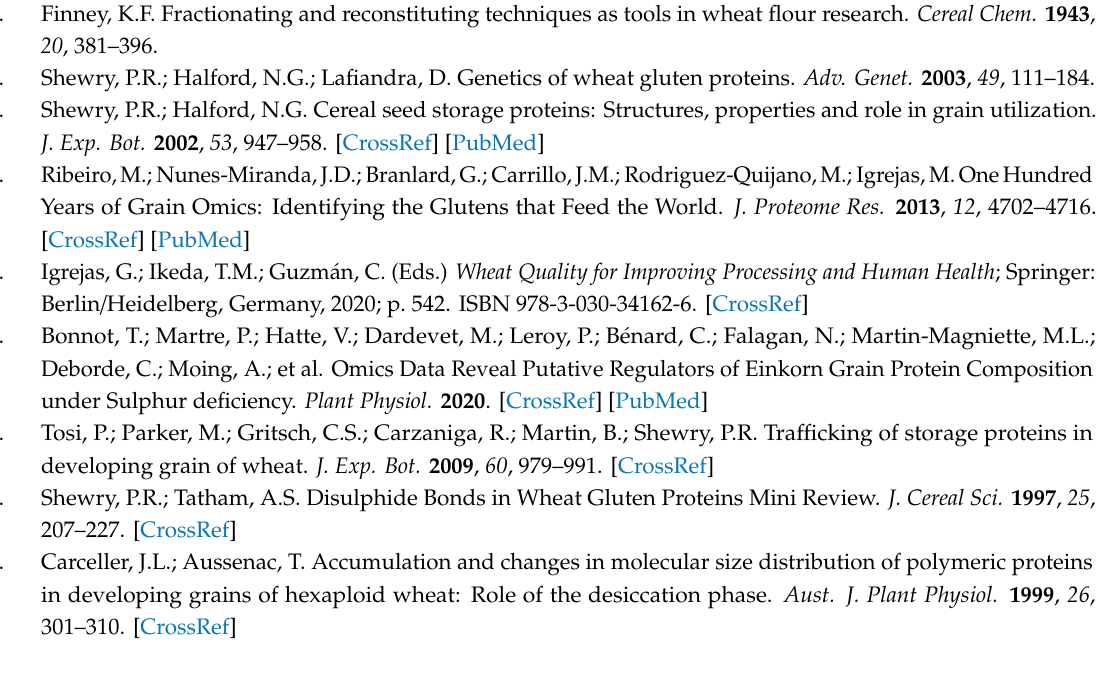
Figure S1: Mean, Min, and Max of the sum of the accumulated daily temperatures per month ( ◦ C) for May, June, and July in the 3 experimental locations in 2004, 2 locations in 2005, and 3 in 2009 and 2010, Figure S2: Mean, Min, and Max of the sum of the accumulated water precipitations per month for May, June, and July in the 3 experimental locations in 2004, 2 locations in 2005, and 3 in 2009 and 2010, Figure S3: Standardized coe ffi cients of the PLS regressions aimed to explain the Mw, Rw, and PI = Mw / Mn characteristics of the polymers, Table S1: Locations and seed companies involved in multilocal trials, Table S2: Frequencies of alleles encoding HMW-GS an LMW-GS in the 192 wheat